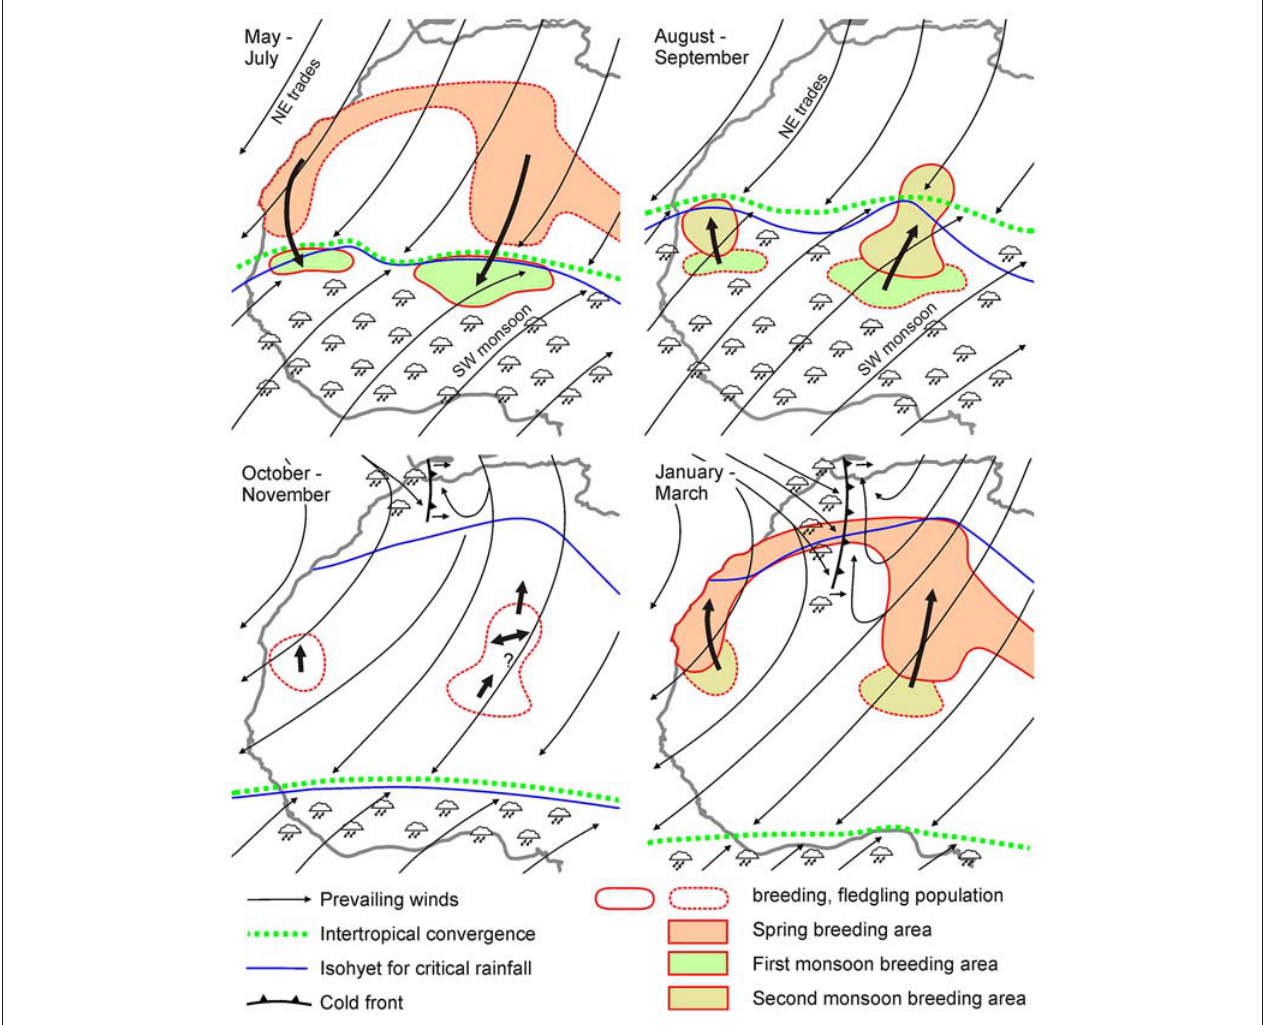
FIGURE 2 | Seasonal movements of different generations of desert locust populations in West Africa in relation to seasonal shifts in the Intertropical Convergence Zone (ITCZ), monsoons and winter rains . Note that migratory directions from January—March (lower right) are against the prevailing wind directions. Data are largely based on migrations of individuals rather than swarms. Adapted from Farrow (1990) after Popov (1965) with kind